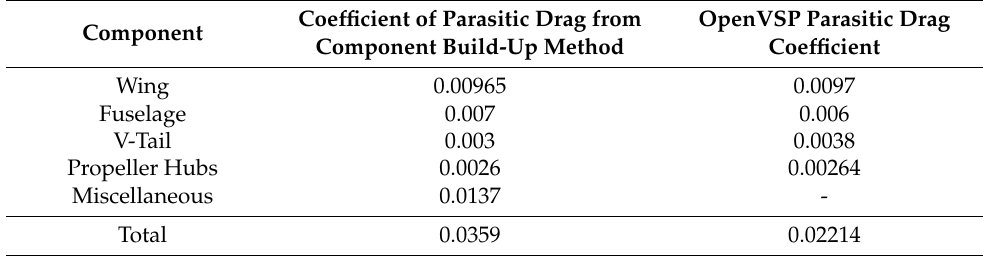
Table 11. Drag contributions by various components.